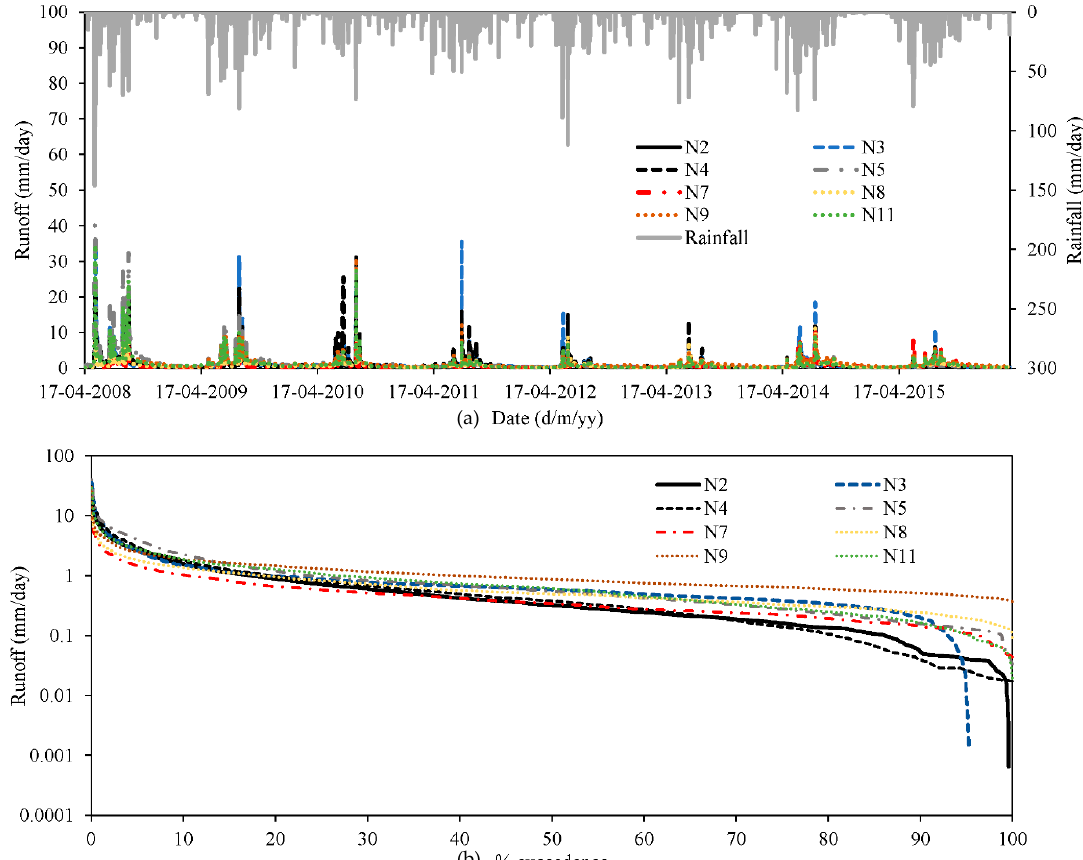
Figure 2. ( a ) Rainfall and runoff observed at the catchment’s outlets. ( b ) Flow Duration Curves for each catchment (All curves were developed using observed daily data).